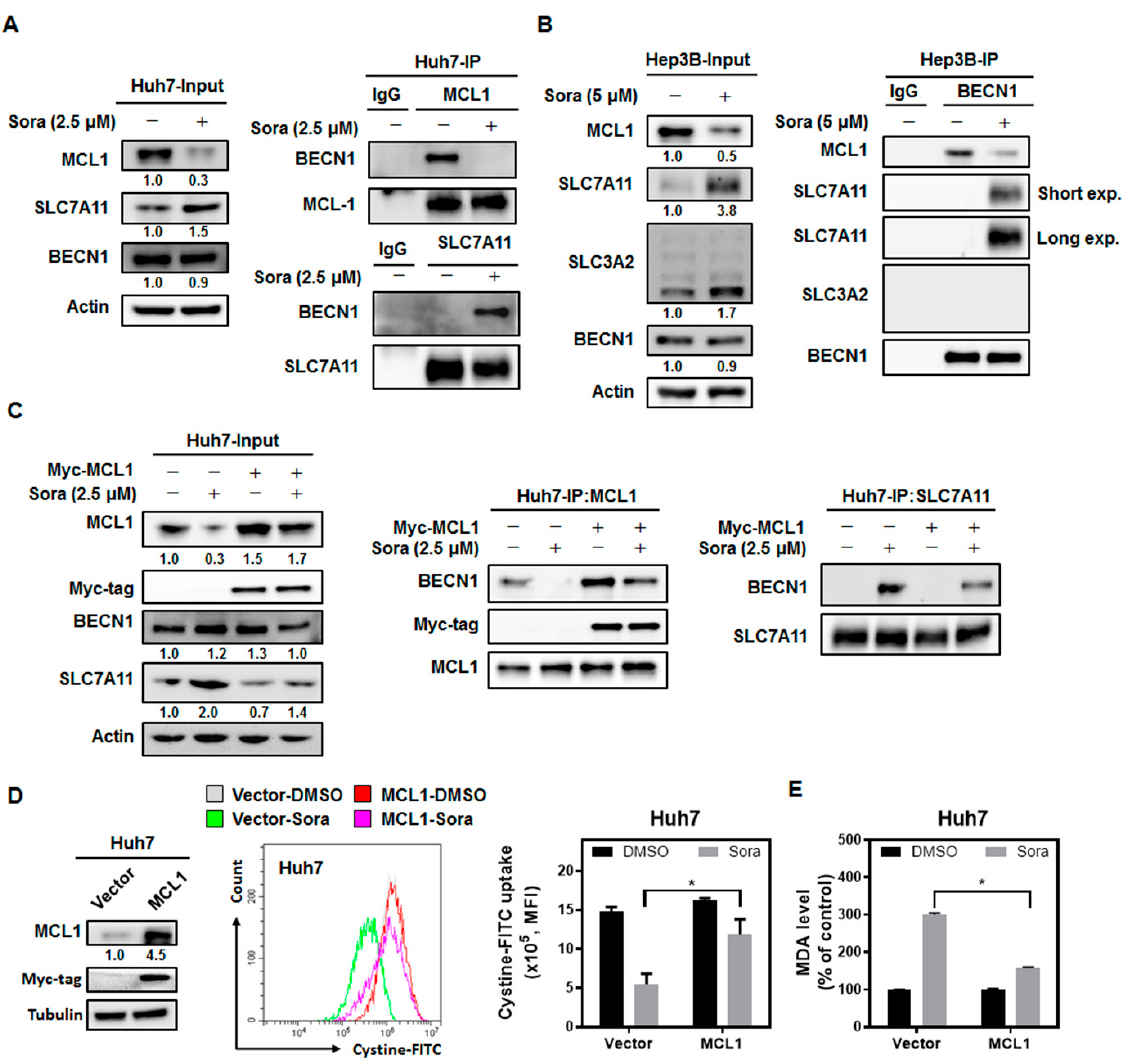
Figure 5. Sorafenib treatment reduces the interaction between MCL1 and beclin 1 (BECN1), while promoting the association between BECN1 and solute carrier family 7 member 11 (SLC7A11): ( A ) HCC cells were exposed to sorafenib (2.5 µM for Huh7 cells and 5 µM for Hep3B cells) for 16 h. MCL1- and SLC7A11-containing lysates were immunoprecipitated from sorafenib-treated Huh7 cells. Protein levels of MCL1, SLC7A11, BECN1, and actin were assayed with Western blots. ( B ) BECN1-containing lysates were immunoprecipitated from Hep3B cells incubated with 5 µM of sorafenib for 16 h. The expression of MCL1, SLC7A11, SLC3A2, and actin was further determined. ( C ) Ectopic expression of MCL1 diminished BECN1-to-SLC7A11 binding and ( D ) recovered the intake of cystine–FITC after 2.5 µM sorafenib treatment for 16 h. Columns: mean; bars: SD (n = 3). ( E ) Ectopic expression of MCL1 reduced MDA content following sorafenib treatment. Columns: mean; bars: SD (n ≥ 3). Statistical significance was analyzed using the Mann–Whitney U test (*, p <0.05).